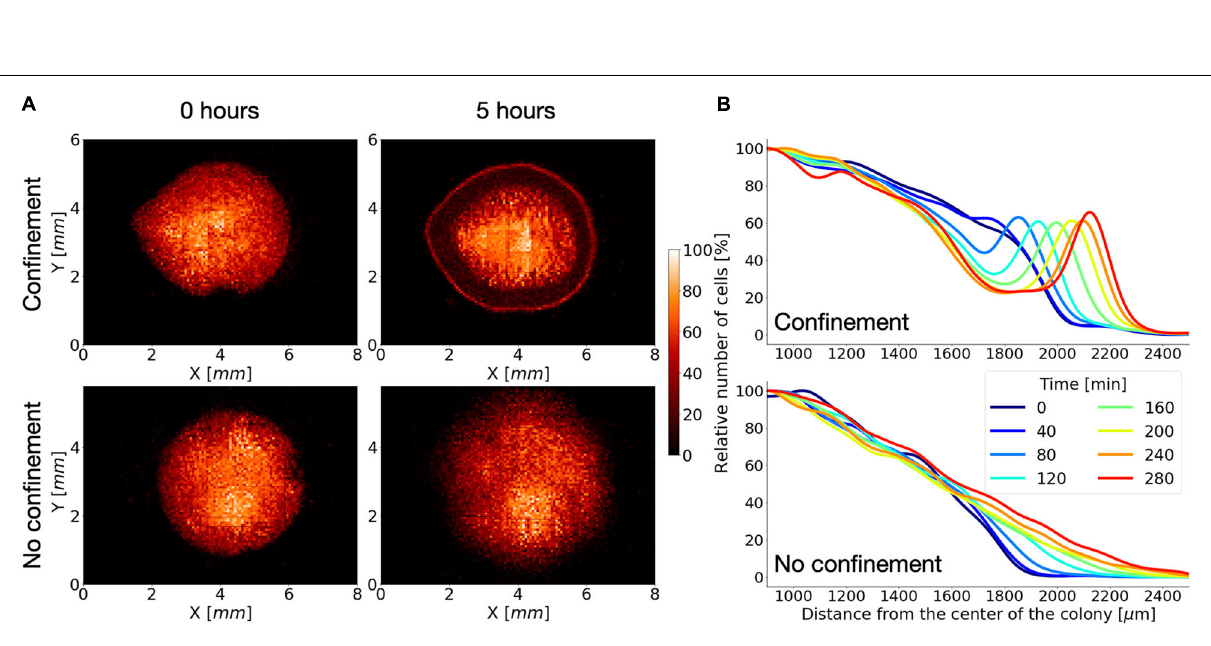
FIGURE 2 | Growing Dictyostelium wild-type cells react to the oxygen gradient. (A) Distribution of cells at the beginning of the experiment and after 5 h under confined (top) or not confined (bottom) conditions. (B) Corresponding cell density profiles (estimated as explained in the section “Materials and Methods”) along the radial direction at different times are